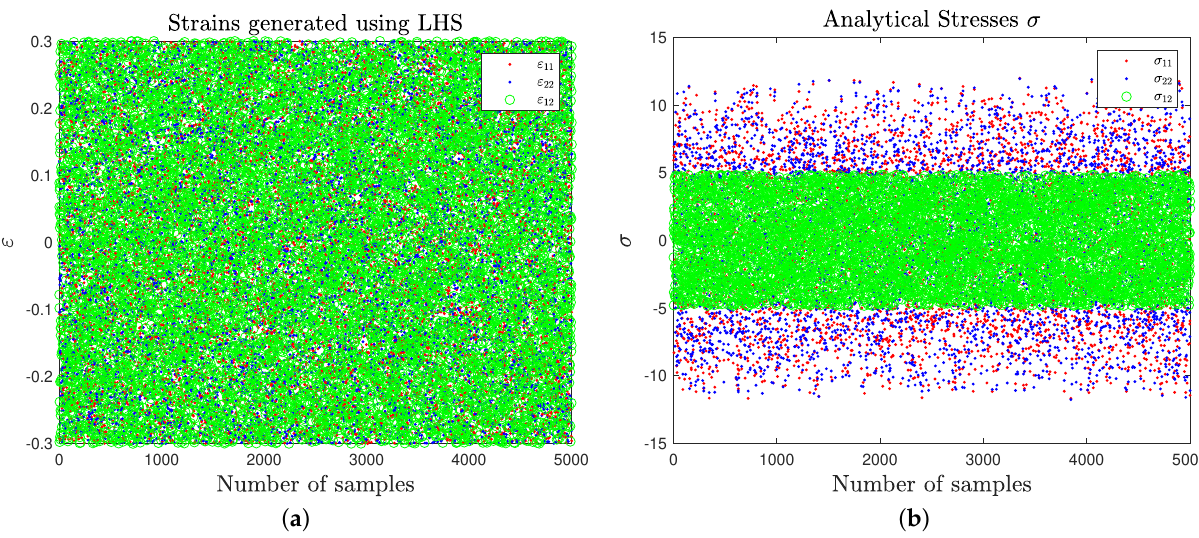
Figure 4. Analytically generated data set. ( a ) Input data—2D strains ε and ( b ) output data—2D stresses σ [kN/mm 2